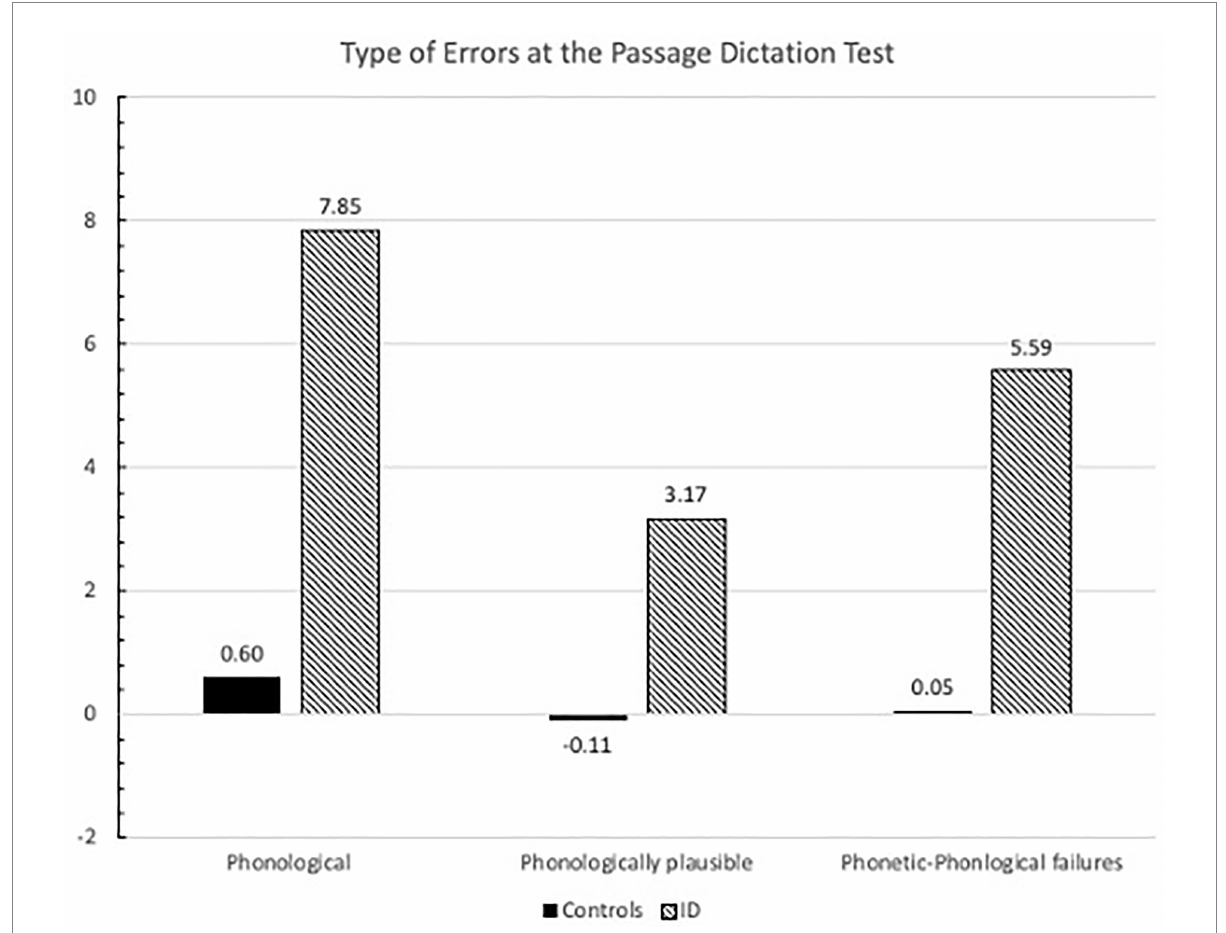
FIGURE 1 Mean error z scores for the three categories of errors at the Passage Dictation Test committed by control and ID